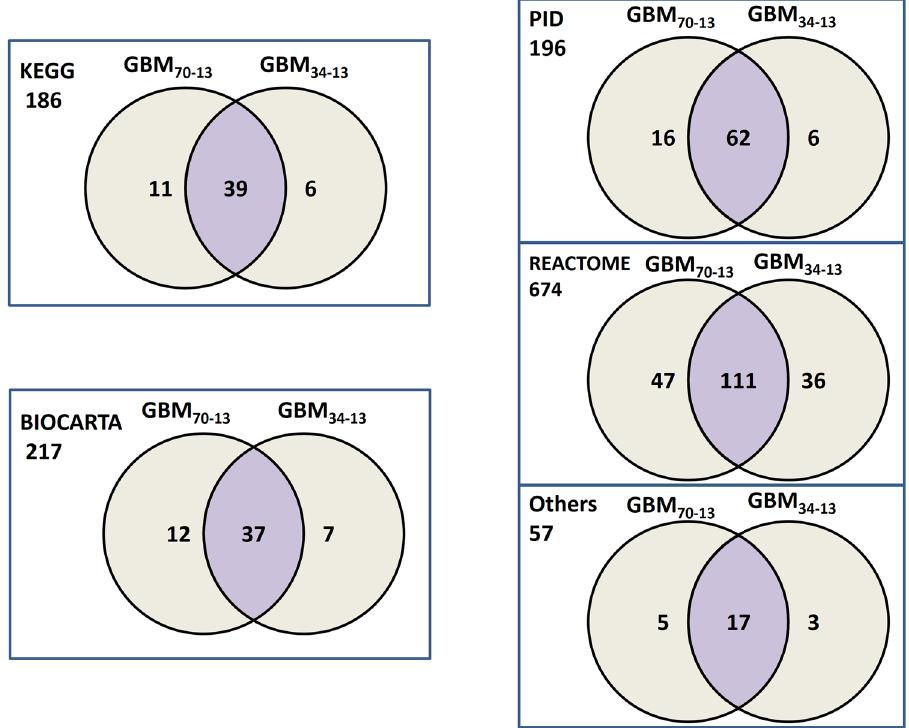
Figure 4. Venn diagrams for the number of significant MSigDB pathways detected for GBM. The 1330 significant MSigDB pathways were divided into five groups according to the source databases, including Biocarta, KEGG, PID, Reactom and the